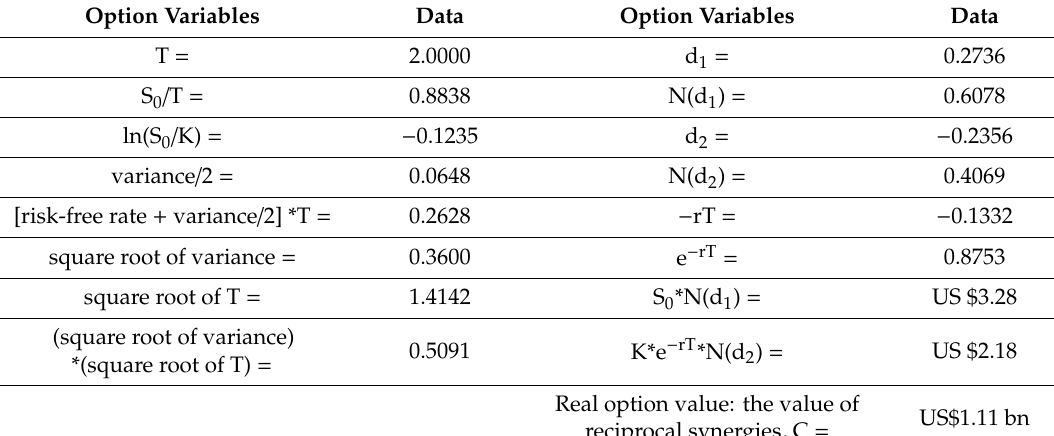
Table 4. Parameters of the Black Scholes option pricing model and the value of reciprocal synergies: European call option value (Natura’s acquisition of The Body Shop, in US$